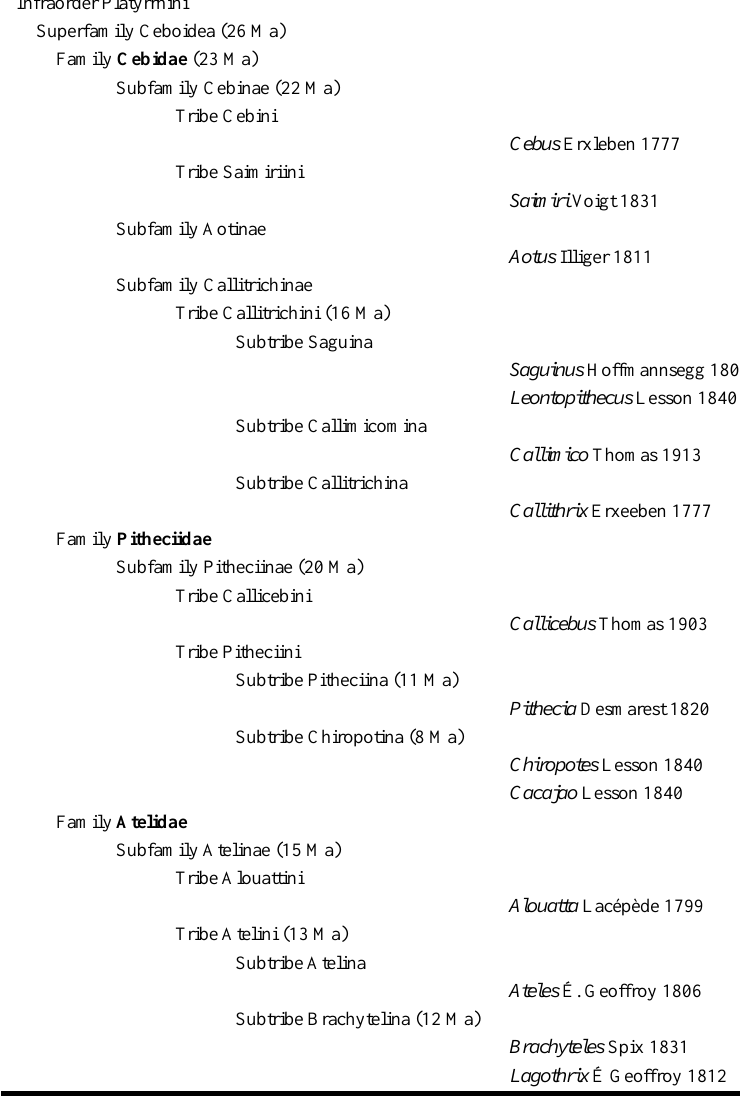
Provisional age-related New World monkeys